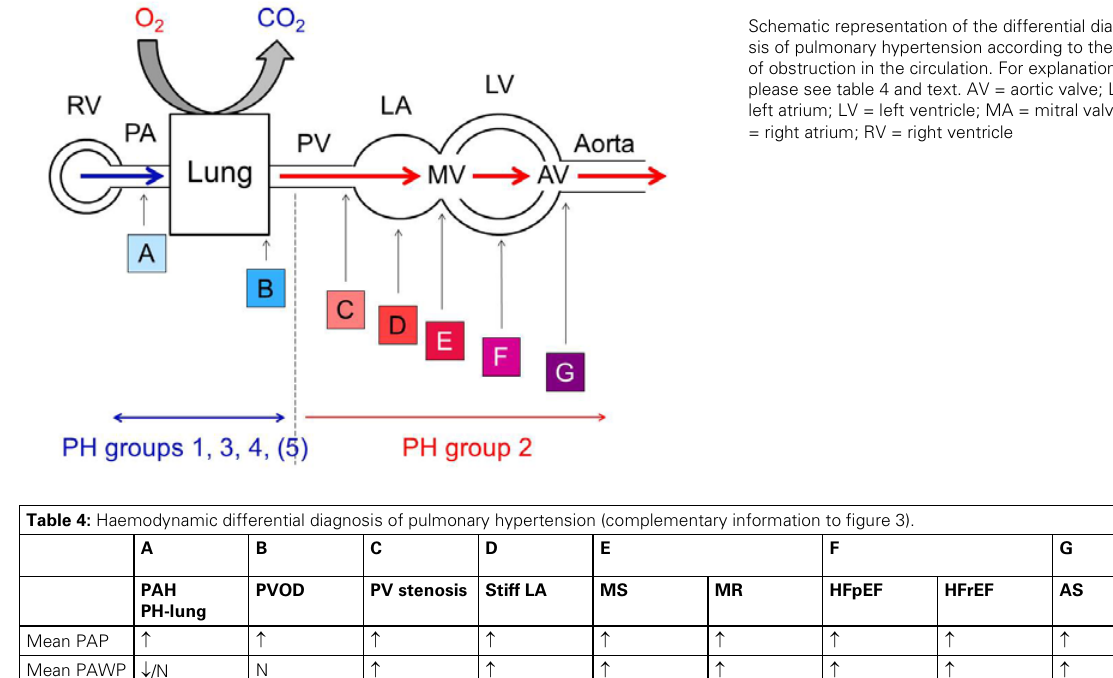
Schematic representation of the differential diagno- sis of pulmonary hypertension according to the level of obstruction in the circulation. For explanation, please see table 4 and text. AV = aortic valve; LA =